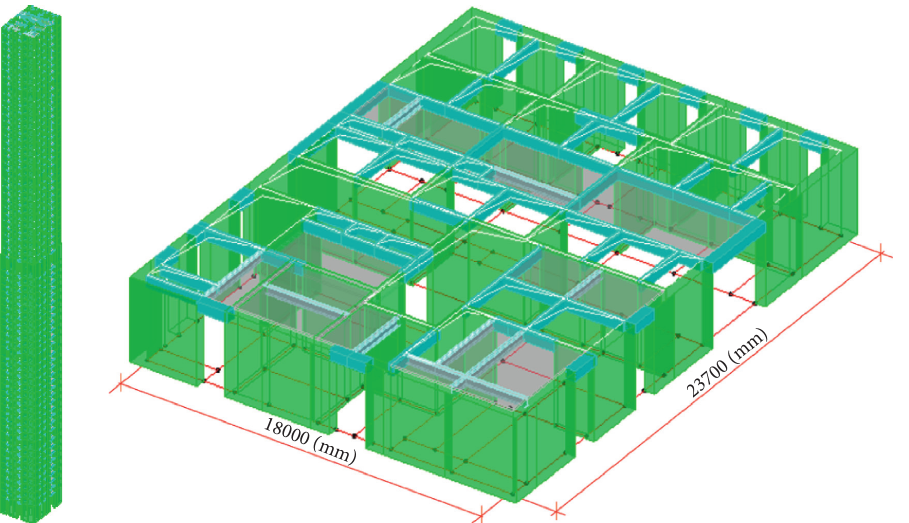
Figure 4: PKPM accurate model of core tube and standard layer structure.